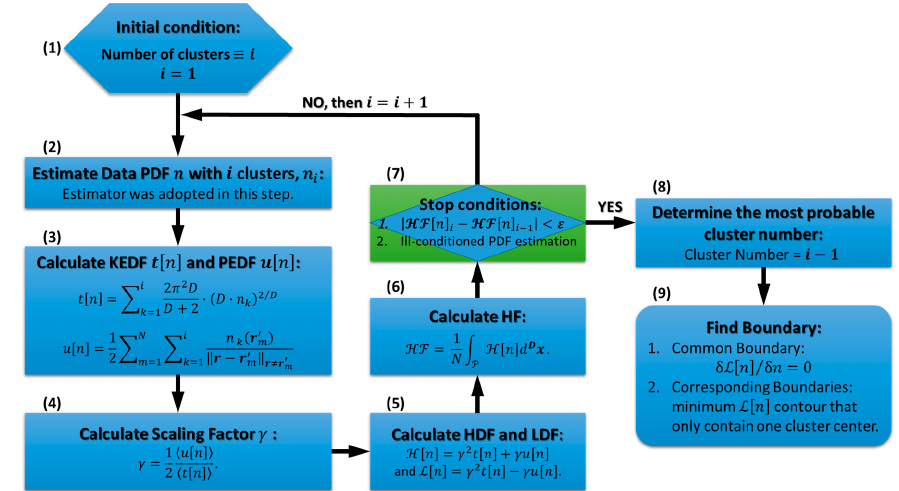
Figure 2. The detail algorithmic flow of the proposed DDFM. Whole algorithm can be divided into two main blocks. In the first block, the main function focuses on finding the most probable cluster number in the studying system. As listed from Steps (1) to (7), the crucial density functionals will be estimated to find the global Hamiltonian functional (HF), so that the most probable cluster number can also be estimated after the process reaches the stop conditions. In the second block, the cluster number will be used to estimate the best Lagrangian density functional (LDF) and the corresponding cluster boundaries can then be delineated by finding either the zero points of the LDF derivative or the lowest level of LDF that only encloses one center.